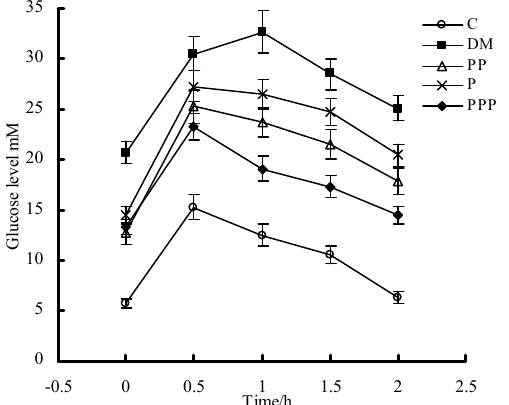
Figure 5. The oral glucose tolerance test of pumpkin polysaccharides and puerarin ( n = 10). C, control; DM, diabetic model; PP, pumpkin polysaccharides; P, puerarin; PPP, pumpkin polysaccharides and puerarin.